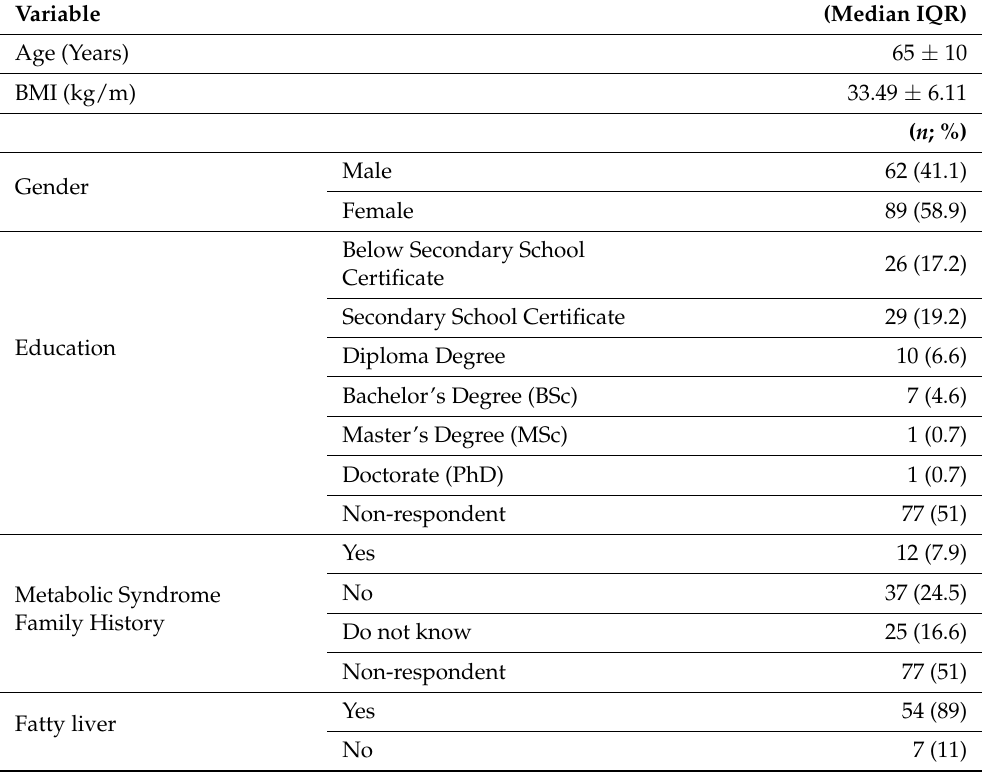
Table 1. The descriptive demographic characteristics of Bahraini population with